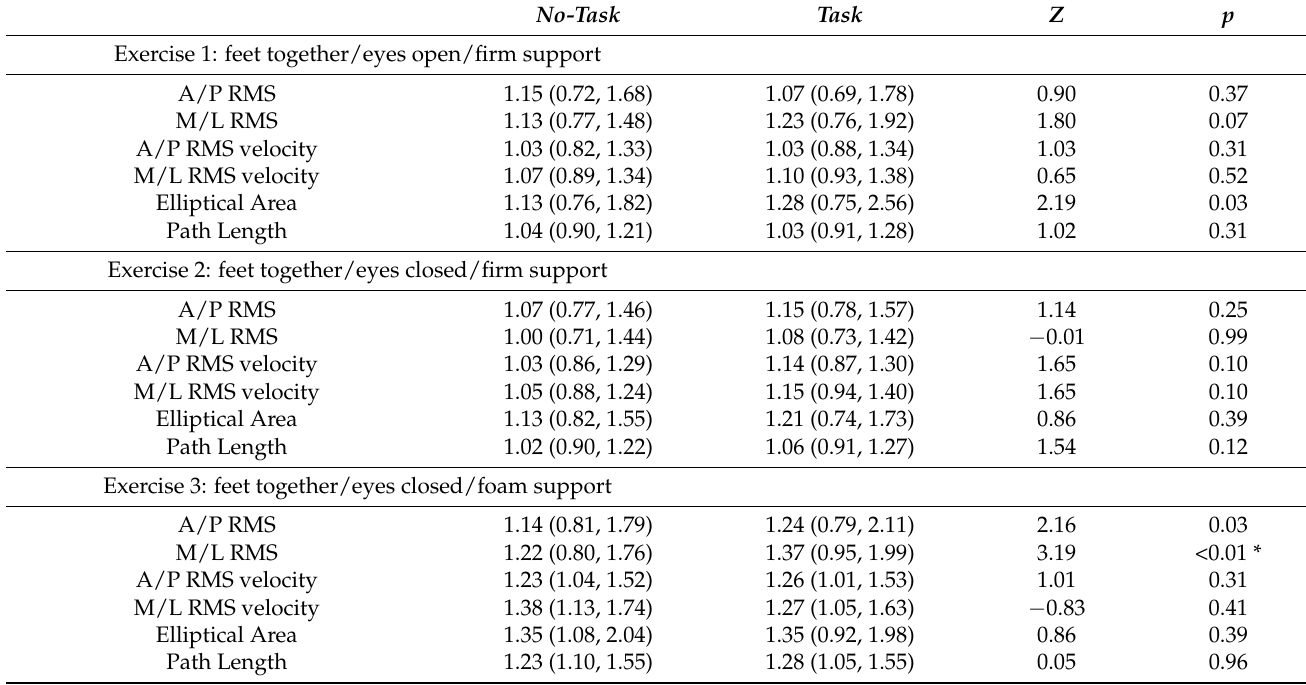
Table 2. Normalized values of the balance metrics for all exercises by Task condition. Median values (1st quartile, 3rd quartile) are shown. An asterisk (*) denotes a significant difference between the No-Task and Task conditions for an